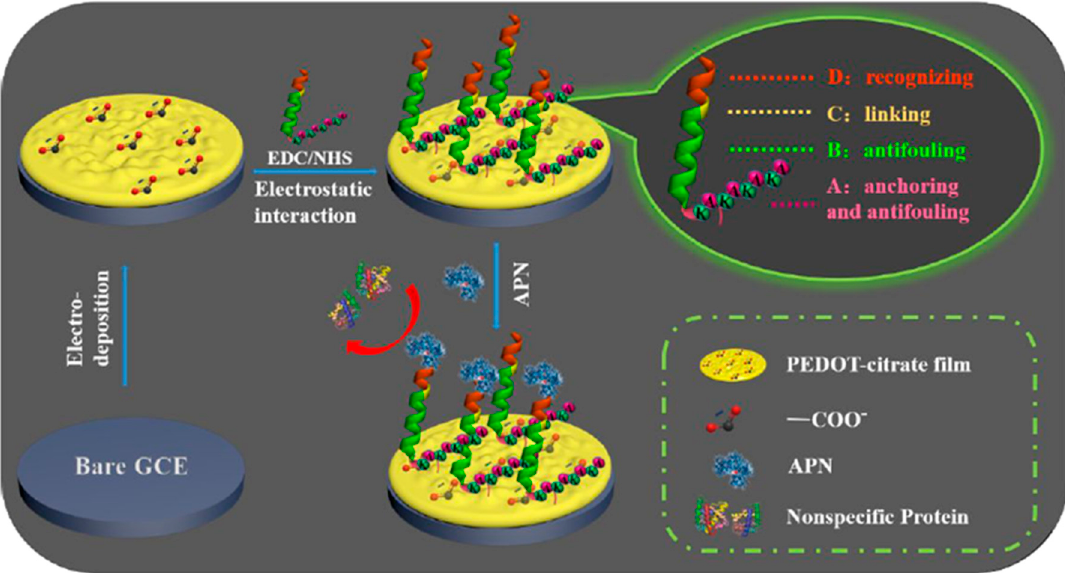
Figure 3. Electrochemical biosensor with antibiofouling properties for the determination of APN and HepG2 cells involving the immobilization of a multifunctional peptide onto a GCE modified with a PEDOT-citrate film. Reprinted from [24] with permission.